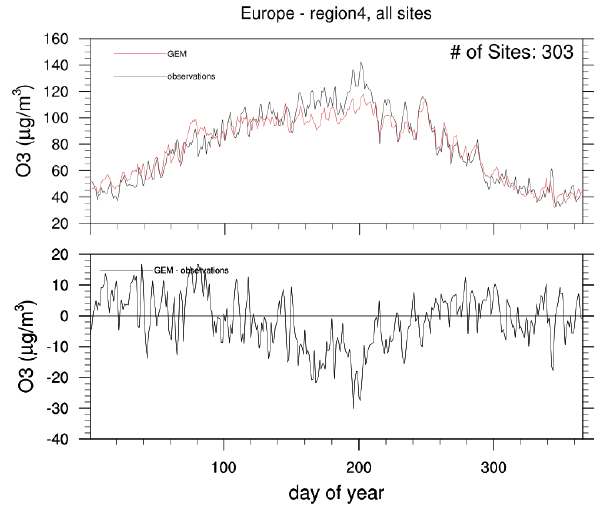
Figure 11. Time series of observed and modelled maximum 8h run- ning averaged ozone concentration averaged for (a) all stations in central Europe and (b) MBE.